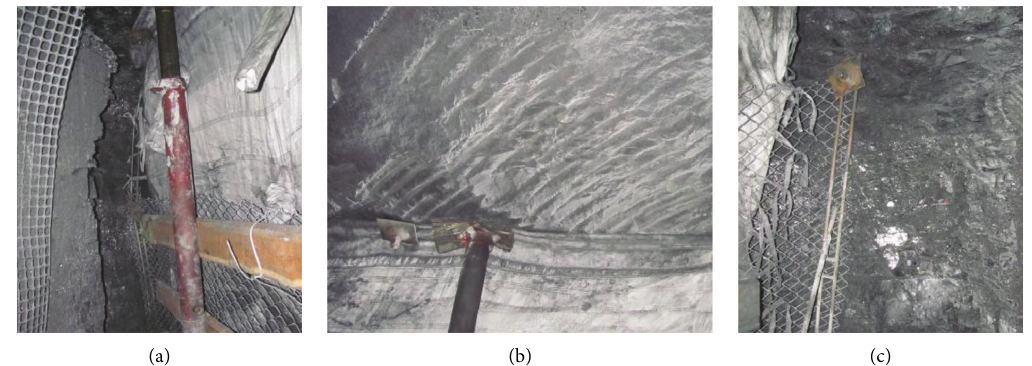
Figure 7: The state of (a) left rib, (b) right rib, and (c) roof.